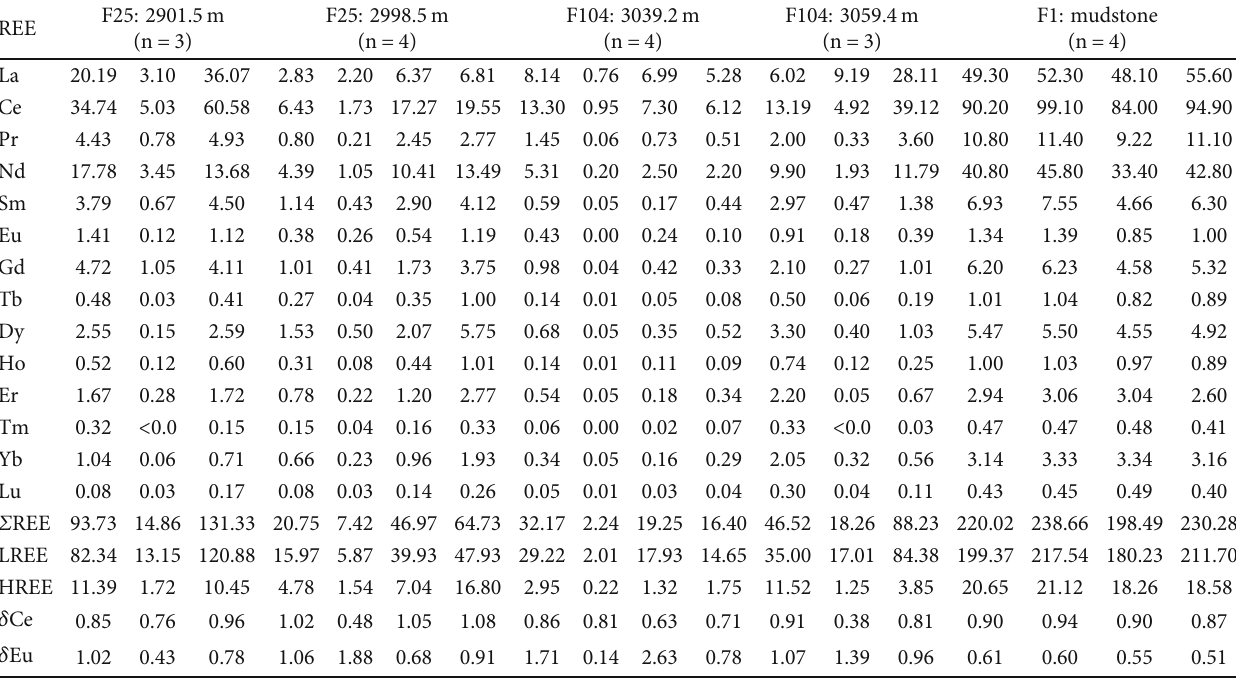
Table 6: The REE data of carbonate cement and mudstone ( μ g/g).